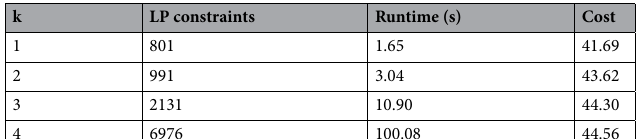
Table 1. Summary of our prevention experiments on the Seattle data. k , in the first column, is the maximal number of nodes in the initially infected patterns (all accounted for to construct the k -Safe Polytope). The second column shows number of linear constraints characterizing the k -Safe Polytope. Respective Run Time and Cost are shown in the 3rd and 4th column, where Cost shows the difference in l 1 norm between the ( J ( 0 ) , h ( 0 ) ) , characterizing stressed but unmitigated regime, and the optimal prevention regime, resulting in (